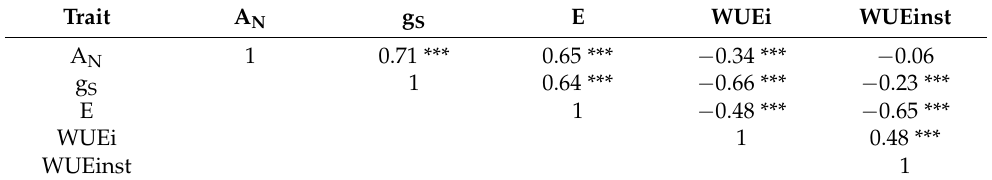
Table 3. Pearson correlation coefficients among best linear unbiased estimators for photosynthetic traits in a large maize association panel evaluated across three consecutive